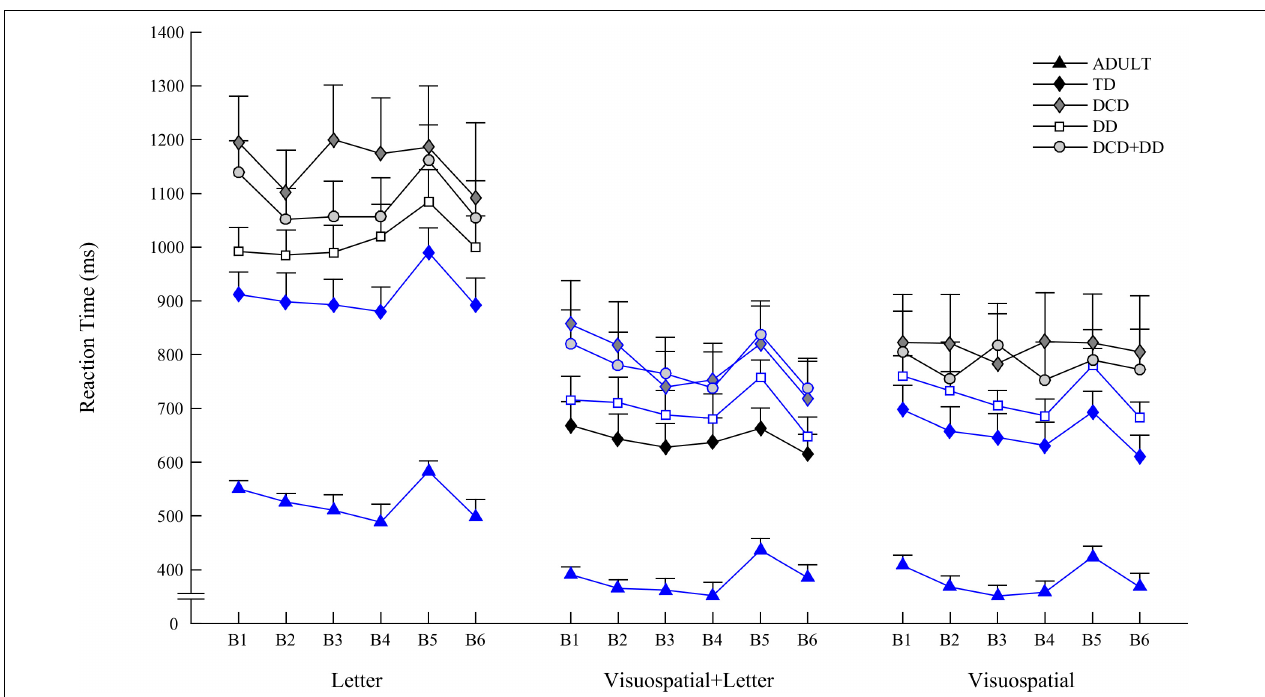
FIGURE 2 | Mean reaction time of adults (black triangle), TD group (black diamond), DCD (gray diamond), DD (white square), and DCD+DD (gray circle) groups for Blocks 1–6 on Letter condition (left) Visuospatial + Letter condition (middle), and Visuospatial condition (right). Blue lines correspond to intact procedural learning. Vertical bars represent inter-individual variability (standard